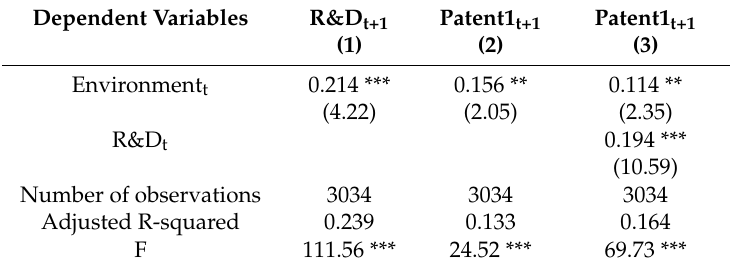
Table 9. Firms with R&D investment information.